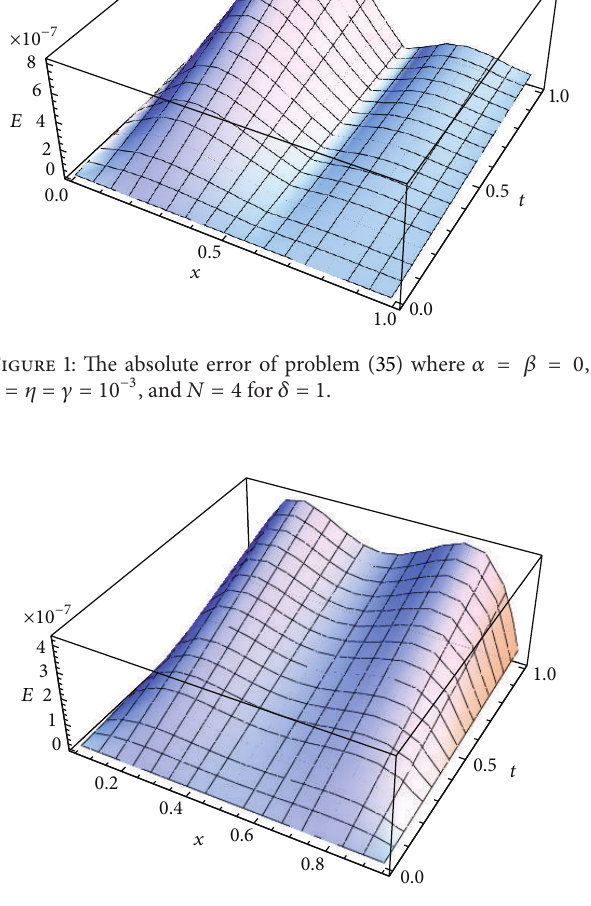
Figure 2: The absolute error of problem (35) where 𝛼 = 𝛽 = 1/2 , ] = 𝜂 = 𝛾 = 10 −3 , and 𝑁 = 4 for 𝛿 = 2 .